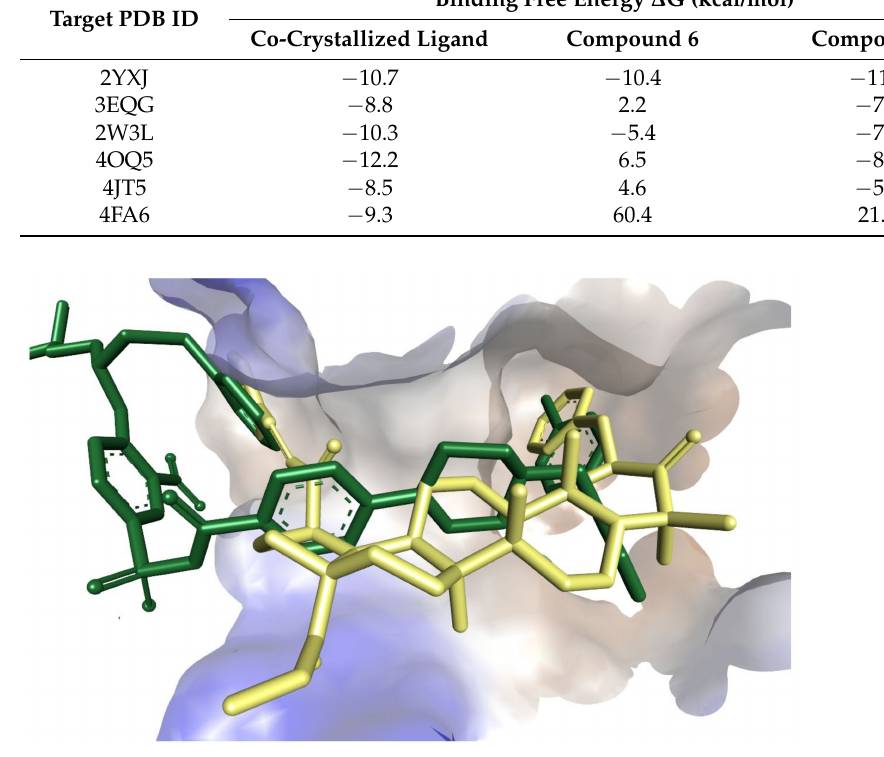
Figure 12. ABT-737 structure (green) overlayed on the docked conformation of compound 7 (yel- low), within the Bcl-XL binding domain, revealing that both compounds occupy the same two hydrophobic pockets.